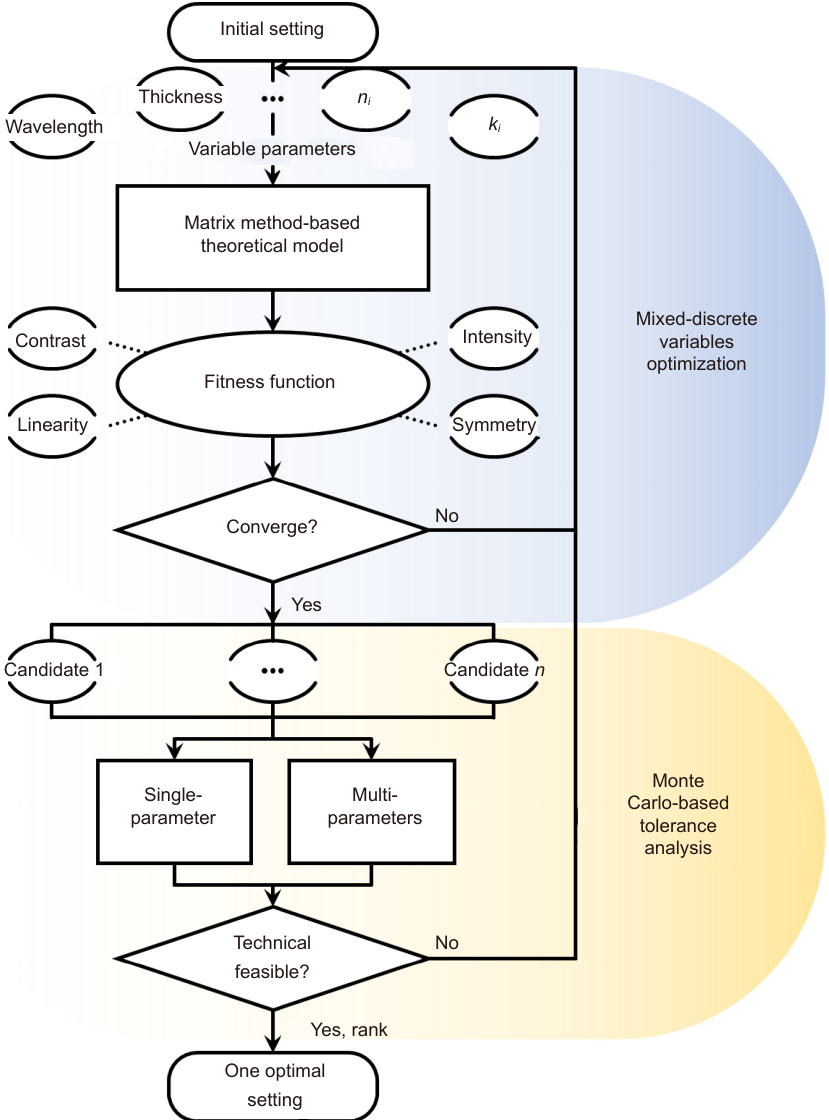
Fig. 3 | Inverse design flow of the F-P cavity that contains the mixed-discrete variables optimization and the Monte Carlo-based toler- ance analysis, wherein the matrix method-based theoretical model serves as the connection between the variable parameters and the fitness